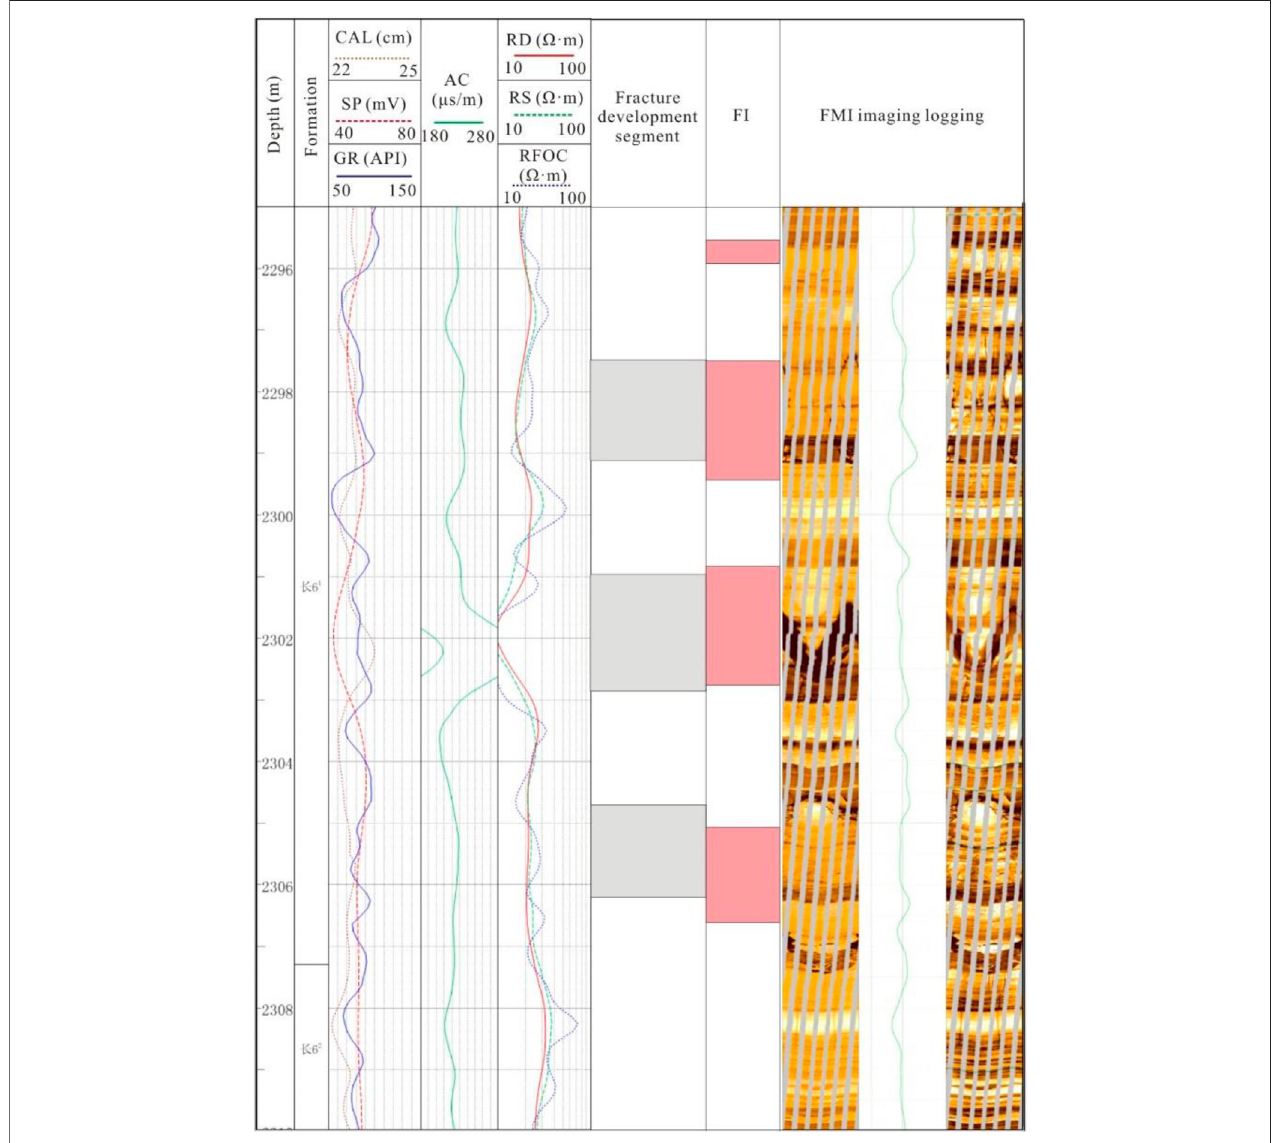
FIGURE 11 | Logging identi fi cation results of the fracture development segment in the sandstone at 2,295 – 2,310 m in Well D2. CAL-well diameter; SP- spontaneous potential; GR-natural gamma; AC- longitudinal wave time difference; RD-deep lateral resistivity; RS-shallow lateral resistivity; RFOC-eight lateral resistivity; FI-fracture